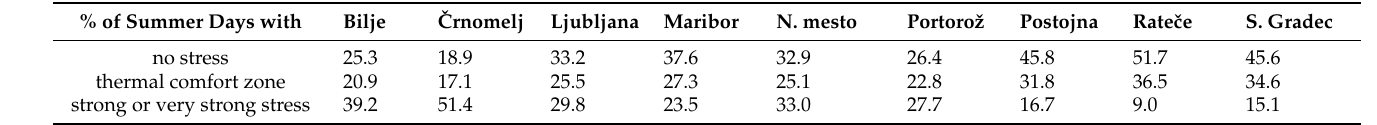
Table 6. The percentage of summer days in the period 2000–2021 within strong or very strong heat stress, thermal comfort zone or no thermal stress for each